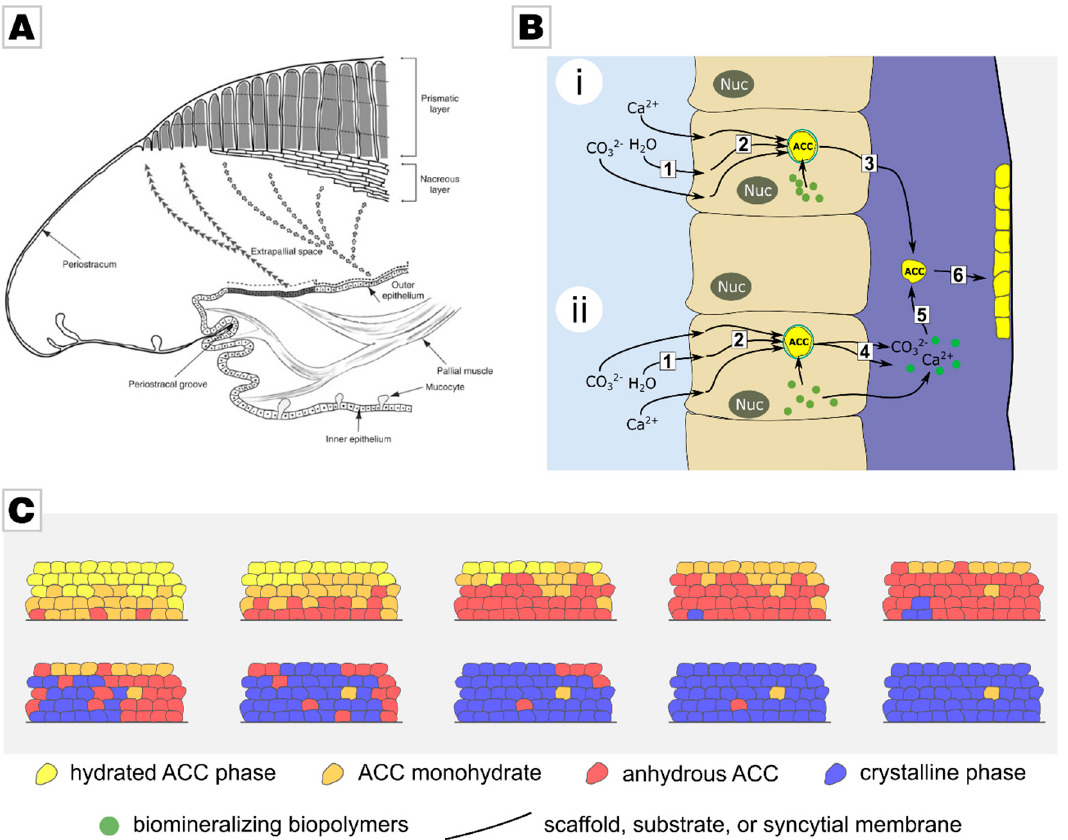
Figure 1. ( A ) Shell mineralization occurs in two compartments, the mantle and the extrapallial space. Reprinted from Marin et al., ref. [6], with permission from Elsevier. ( B ) Two generic mineralization pathways possible within the second compartment. (1) Uptake of ions from the environment. (2) Ion storage in intracellular compartments, e.g., as amorphous calcium carbonate (ACC) nanoparticles. (3) Exocytosis of calcium carbonate can occur by redissolution to ions or by the export of the stored ACC granule. (5) ACC colloids can reform from ions, under process-guidance of biopolymers. (6) Attachment of nanoparticles to the growth site. Reprinted from Wolf et al., ref. [19], with permission from Elsevier. ( C ) Transformation of hydrated ACC to crystalline calcite; starting with highly hydrated ACC, losing water, and by first forming monohydrate and then ACC, before crystallization. Reprinted from Wolf et al., ref. [19], with permission from Elsevier.